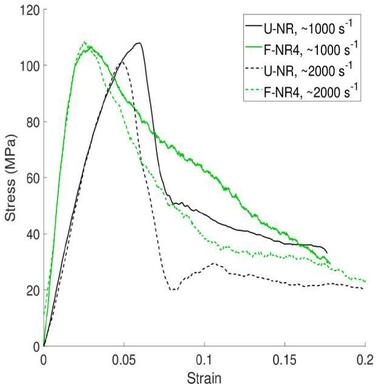
Comparison of high strain rate data from SHPB experiments at − 60 ◦C for the unfilled (U-NR) and 50% large particle filled (F-NR4) materials.